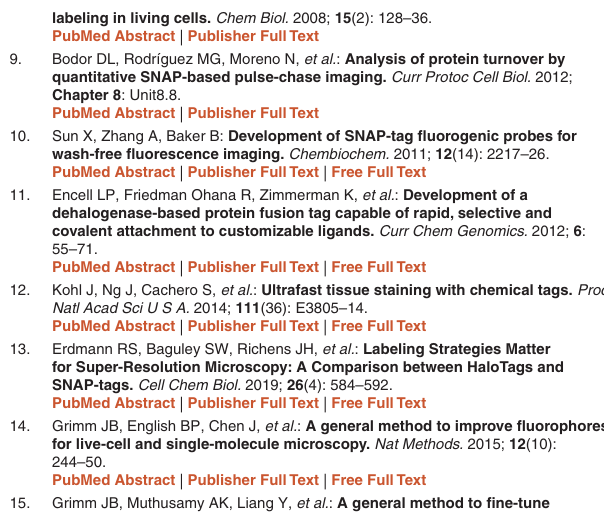
Figshare: A non-fluorescent HaloTag blocker for improved measurement and visualization of protein synthesis in living cells. https://doi.org/10.6084/m9.figshare.12115509.v1 38